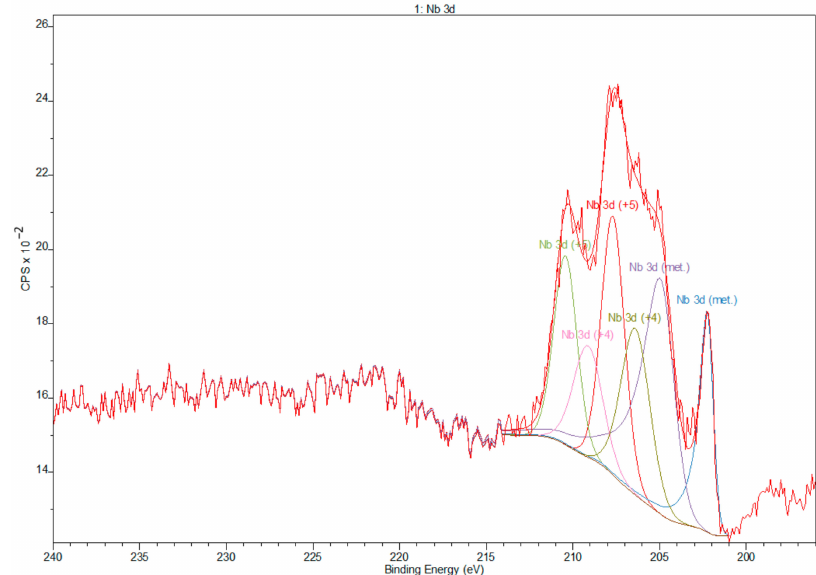
Figure 6. Deconvolution XPS spectra of niobium.